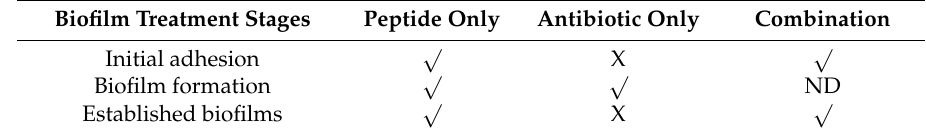
Table 3. Impact of peptide, antibiotics and their combinations on biofilms of P. aeruginosa a .